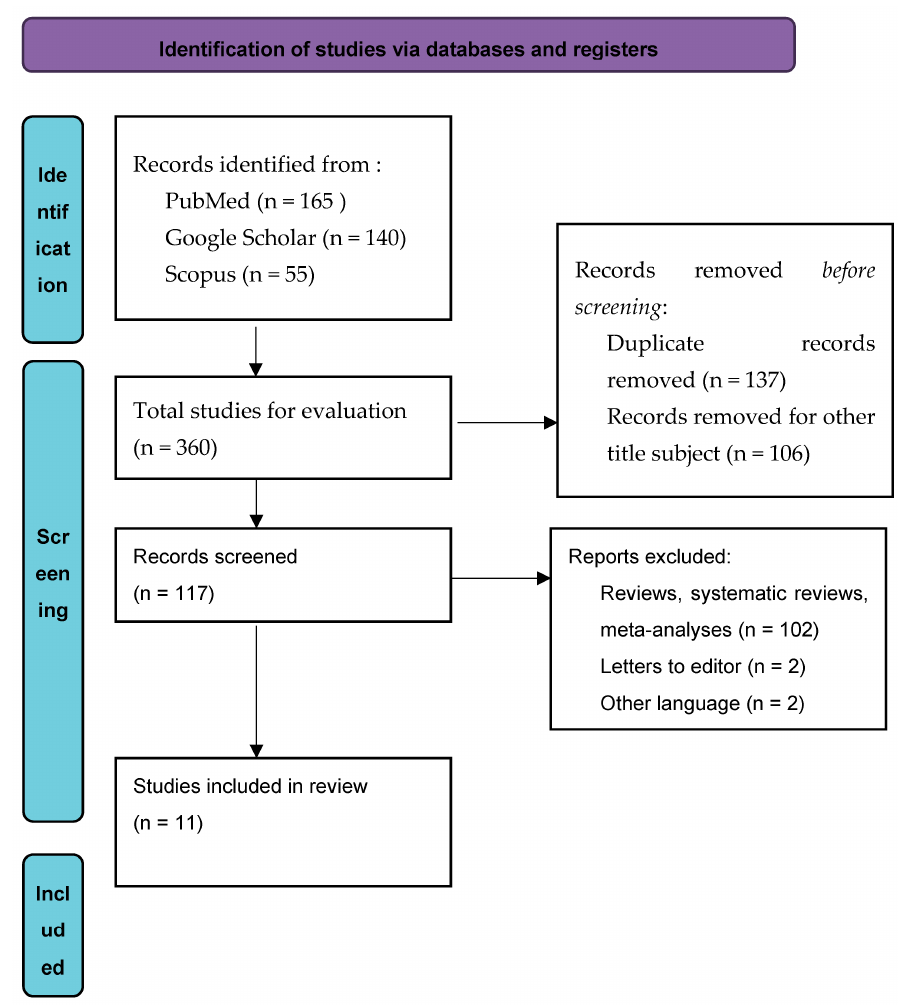
Figure 1. Flow diagram of included papers.